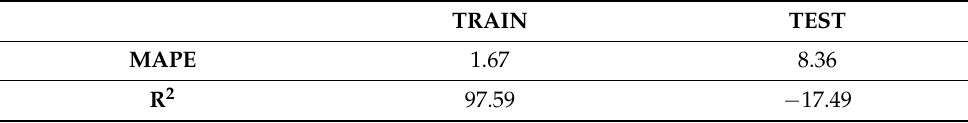
Figure 20. Prediction of humidity inside the hive using gradient boosted decision trees. Zooming in the test period. 4. Concluding Remarks and Further Steps This work is about monitoring bioecological time series data originating from inside a beehive with a view to identify health hazards to the colony. A custom, low cost and power sufficient multisensory recorder gathers data from CO 2 concentration (ppm), con- centration of volatile compounds (ppb), temperature and humidity as well as counts of bees entering and exiting the hive. The platform also transmits exact sampling time, GPS coordinates and weight. These data constitute a multidimensional time series that can be analyzed by machine learning techniques to identify current trends in sensors’ values, predict future outcomes and regions of confidence around them but, most of all, identify atypical values that may relate to hazardous situations for the health of the beehive. In this work, we present our open, optimized in terms of electronic components and power, smart beehive, we comment on the multidimensional time series produced and we dis- cuss ways machine learning techniques can be integrated to a decision support system that issues alert messages. The following step, besides transmitting multidimensional data to be interpreted at the server, is to transmit direct estimation in the beehive of the health status (i.e., edge computing) that will allow beekeepers, researchers, and public authorities to be active participants in colony surveillance programs with increased accuracy and responsiveness. Our work, among many other, equally competitive approaches, [51–52] have a common